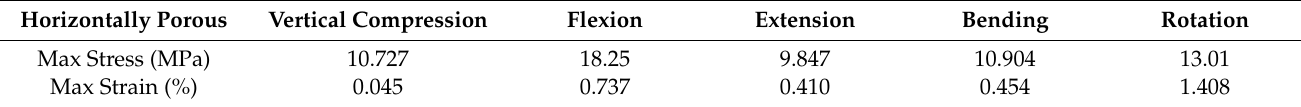
Table 13. The max stress and strain of the horizontally porous gradient structure.